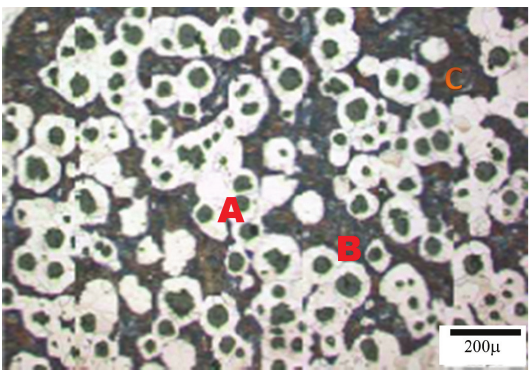
Figure 1. Microstructure of the NCI without Niobium (A = Ferrite, B = Graphite, C = Pearlite - optical microscopy).